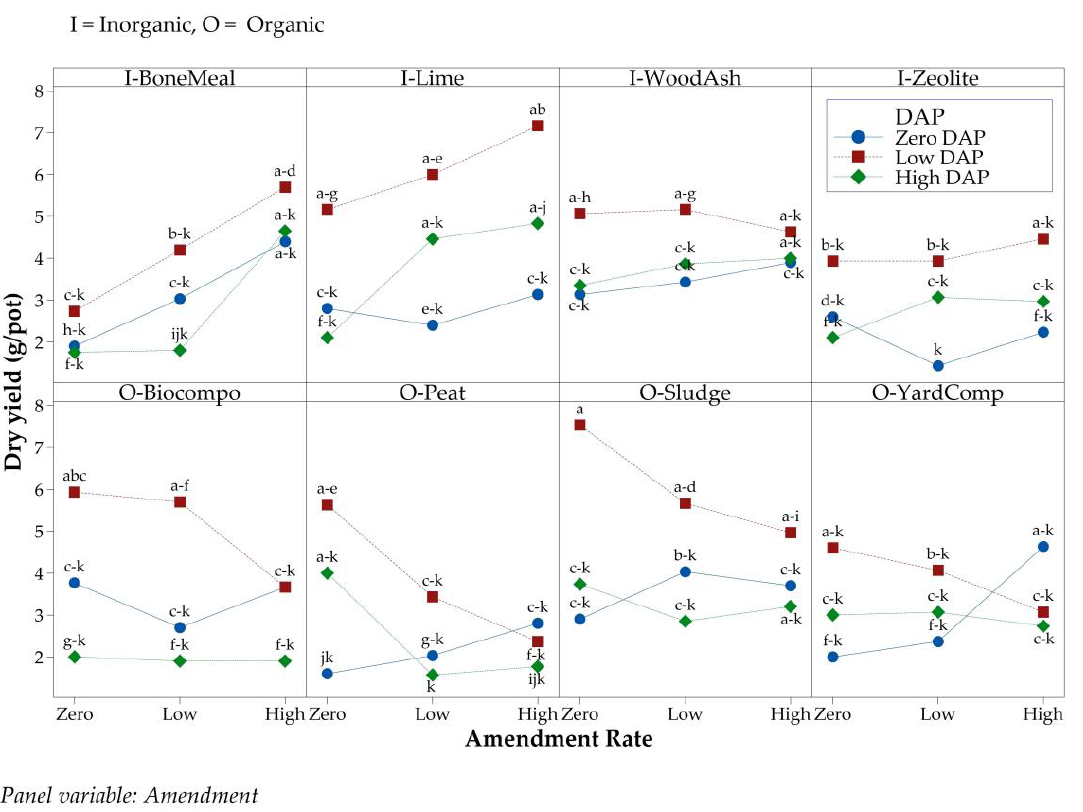
Figure 1. Amendment*Rate*DAP Interaction effect on carrot dry yield (g pot − 1 ). The amendments are grouped as Inorganic (I) and organic (O). Means sharing the same letter are not significantly different.